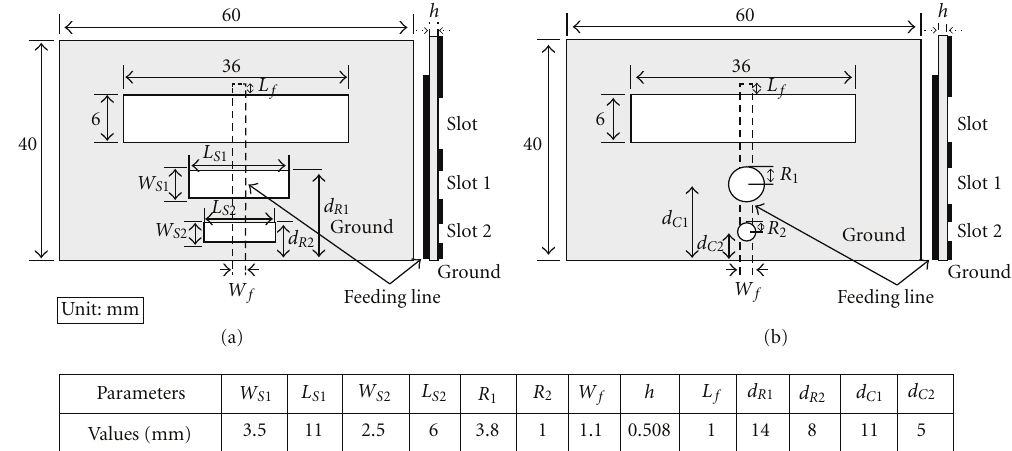
Figure 1: Configuration of the two proposed antennas with their optimal parameters: (a) geometry of rectangular DGS slot antenna and (b) geometry of circular DGS slot antenna.